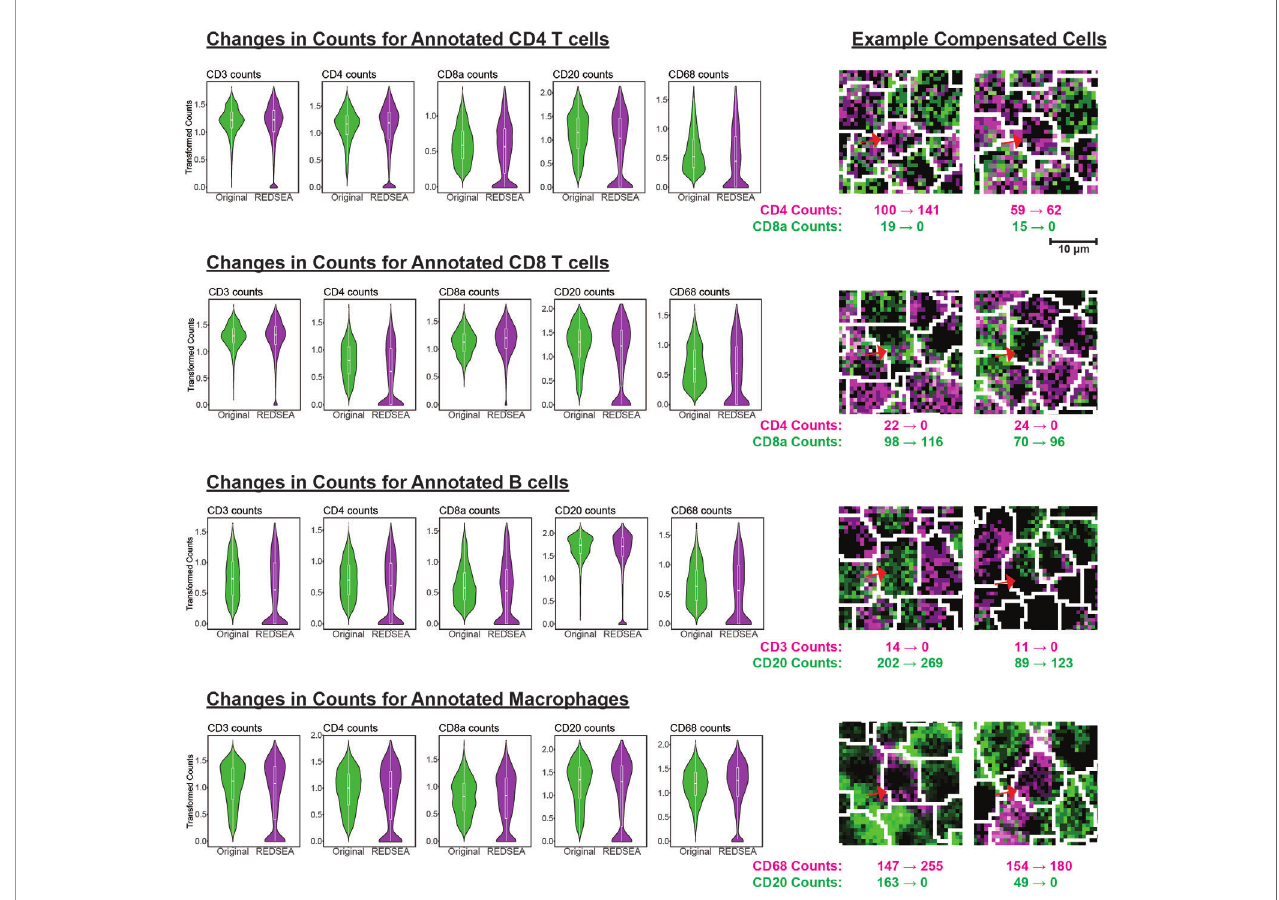
FIGURE 2 | REDSEA Reduces Non-Speci fi c Spillover Signals. Left: Arcsine and square root transformed counts per cell for CD3, CD4, CD8a, CD20, and CD68 were plotted before and after REDSEA border compensation for each of the cell types identi fi ed. Right: Representative images of each cell type with marker counts before and after REDSEA